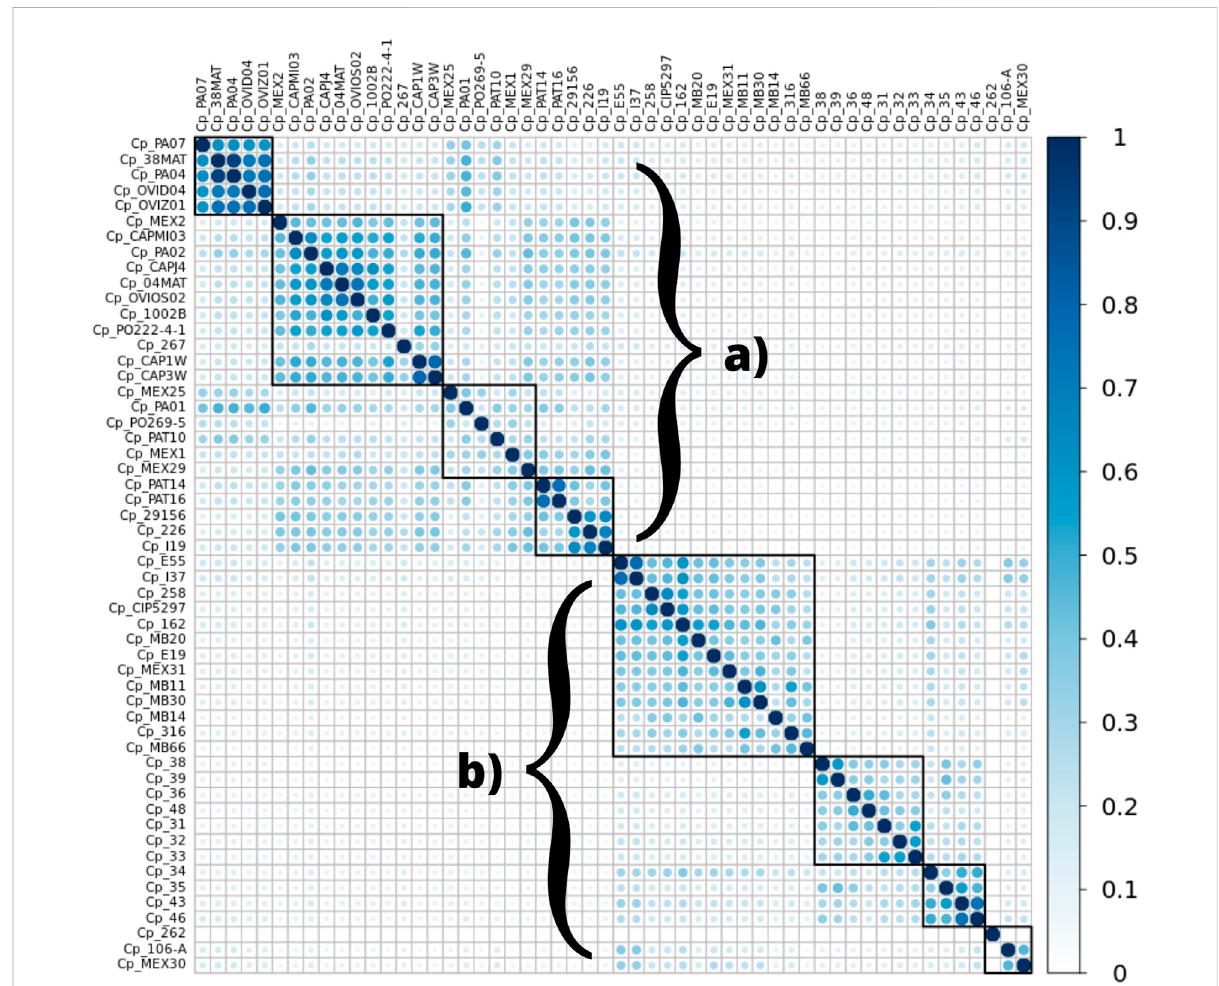
FIGURE 4 Heatmap demonstrating the similarity between microsatellite regions among the 54 genomes of C. pseudotuberculosis in this study, in particular displaying a signi fi cant separation between biovars ovis (A) and equi (B) . The similarity observed is displayed on a color scale from blank to light blue to darker blue (a greater number of identical